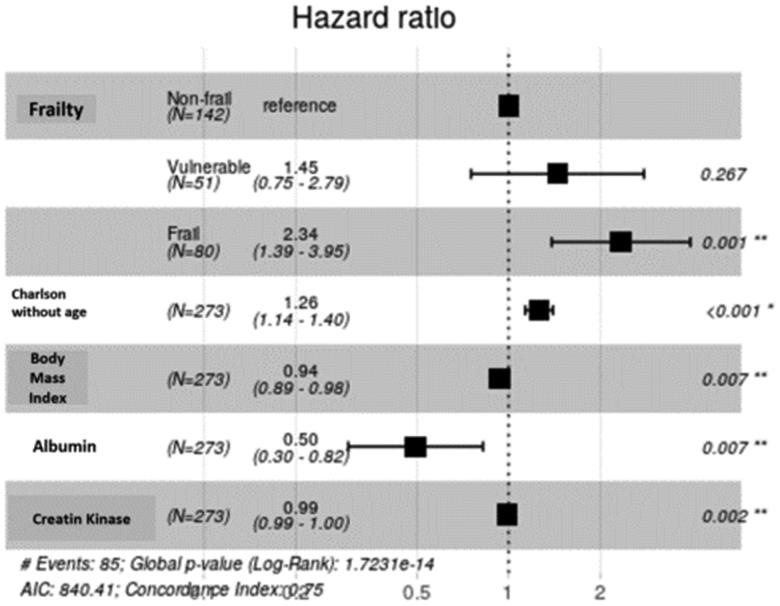
Multivariable Cox proportional hazards models of the association of frailty and mortality adjusted by Charlson Comorbidity Index without age, body mass index, serum albumin, and creatin kinase.